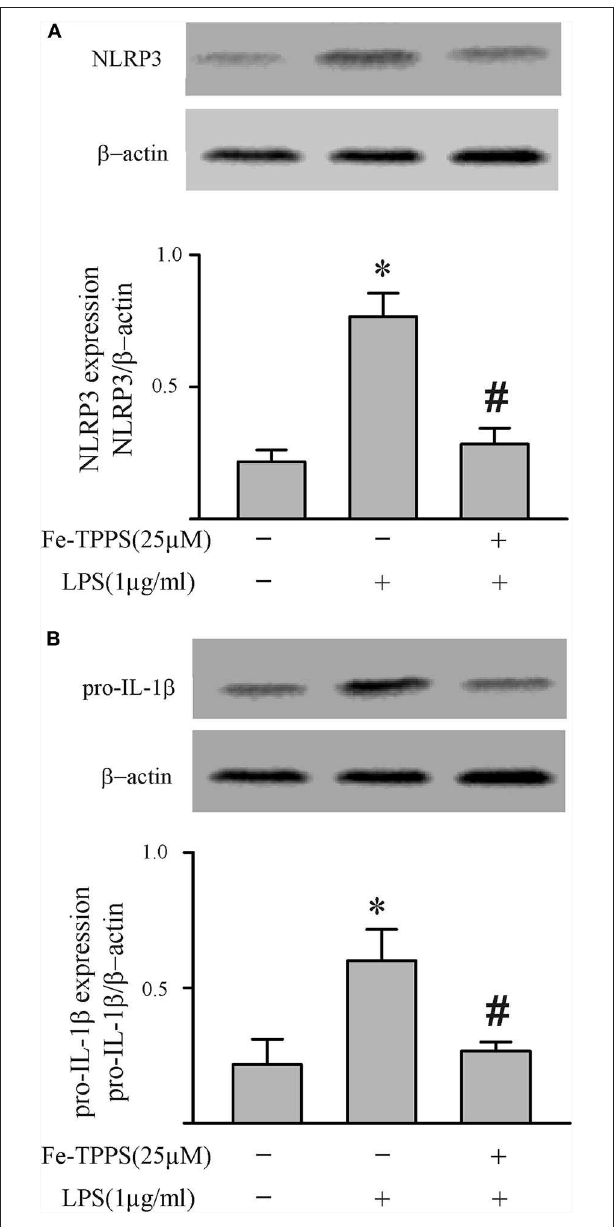
FIGURE 8 | A peroxynitrite decomposition catalyst (Fe-TPPS) decreases LPS-induced priming of the NLRP3 inflammasome. Fibroblasts were pretreated with Fe-TPPS (25 µ M) or vehicle for 30min and subsequently challenged with LPS (1 µ g) for 6h. As indices of inflammasome priming, NLRP3 (A) and pro-IL-1 β (B) protein levels were assessed (Western blot). Representative blots are shown above and densitometric analyses below. n = 3, * p < 0.05 as compared with control; # p < 0.05 as compared with LPS.